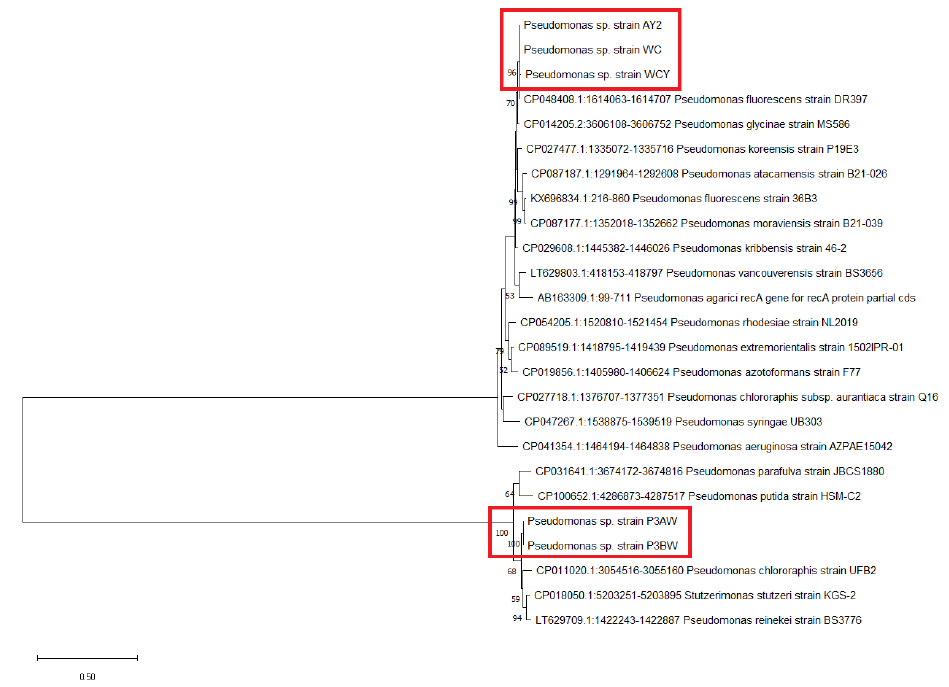
Figure A3. Maximum likelihood phylogenetic tree of Pseudomonas sp. Strains based on the recA gene. The number at the branches indicates the percentage of occurrences of that branch over 1000 bootstrap replications, with values under 50% hidden. Pseudomonas sp. strains from Agave palmeri are circled by the red box.